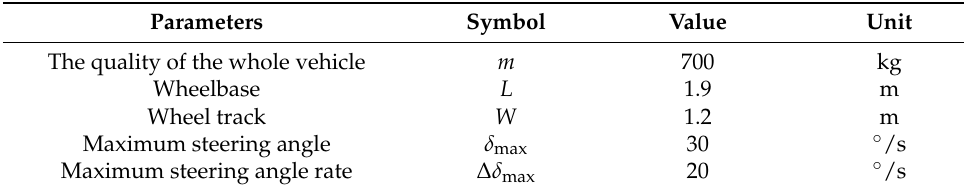
Figure 4. Steer-by-wire electrical system for Chassis of 4WS vehicle. The main structural parameters of 4WS AGV are shown in Table 1. Table 1. Vehicle parameters.